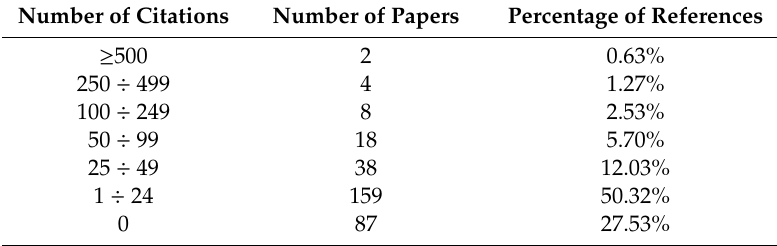
Table 4. General citation structure in sustainable business models research in Scopus. Number of Citations Number of Papers Percentage of